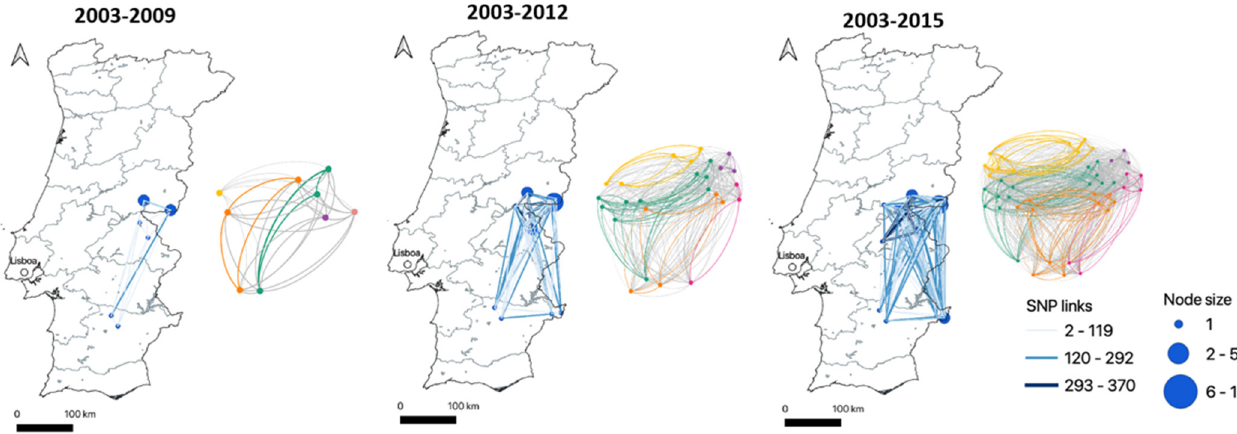
Figure 4. Temporal evolution of the SNP network established for the 44 M. bovis recovered between 2003 and 2015. Three cumulative time periods were considered according to the epidemiological scenarios in Portugal (see methods). In the map of Portugal, the nodes represent M. bovis strains and the complexity of connections is based on the number of shared SNPs between strains. The side network evidences the relationship established between M. bovis grouped within the same clade—each node represents one M. bovis strain and the colors identify the connections according to SNP clade (A—dark cyan, B—orange, C—purple, D—pink, E—yellow and grey for connections between different clades).